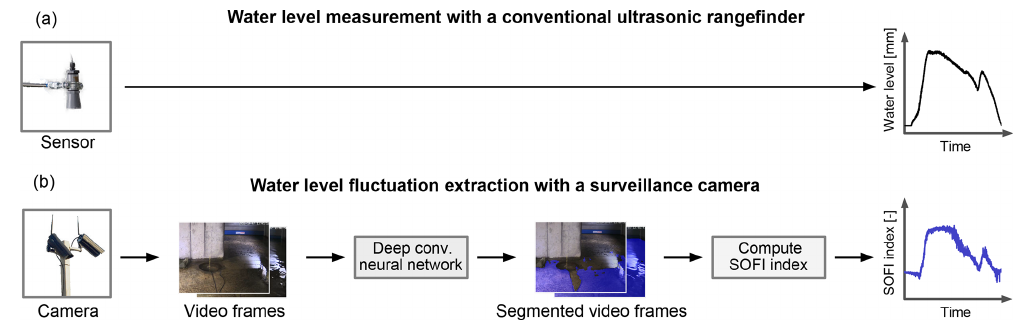
Figure 1. As an alternative to conventional sensors (a) , flood trend information is extracted from surveillance footage by computing the fractional water-covered area (SOFI) over a series of video frames (b) .